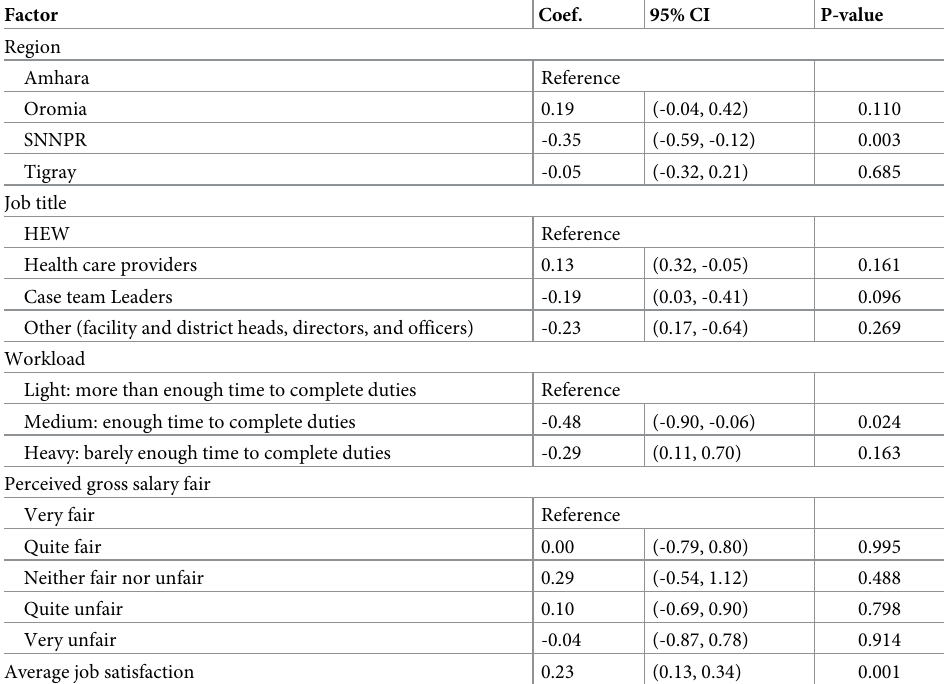
Table 4. Factors associated with overall motivation among participants form four regions April 15–May 10, 2018.